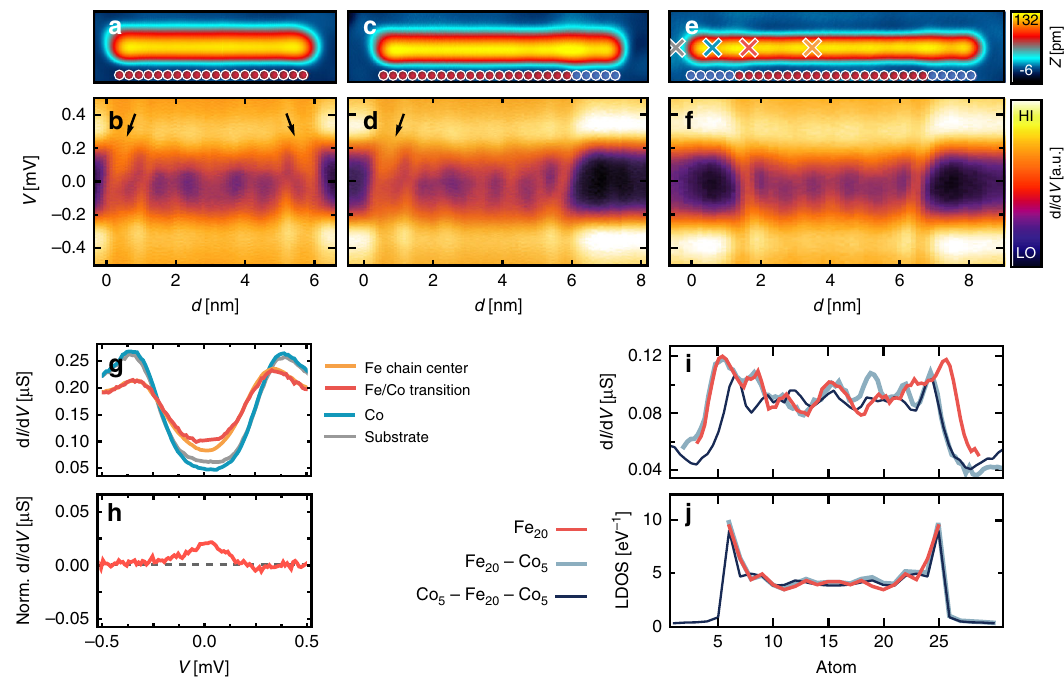
Fig. 4 In-gap states of the Fe 20 chains without and with Co 5 termination. a Constant-current scanning tunneling microscope (STM) image of the Fe 20 chain. b Differential tunneling conductance along the Fe 20 chain aligned with the topography in ( a ). c Constant-current STM image of the Fe 20 – Co 5 chain. d Differential tunneling conductance along the Fe 20 – Co 5 chain. e Constant-current STM image of the Co 5 – Fe 20 – Co 5 chain. f Differential tunneling conductance along the Co 5 – Fe 20 – Co 5 chain. Arrows in ( b , d ): see text. g d I /d V spectra of the Co 5 – Fe 20 – Co 5 chain taken at the positions marked by